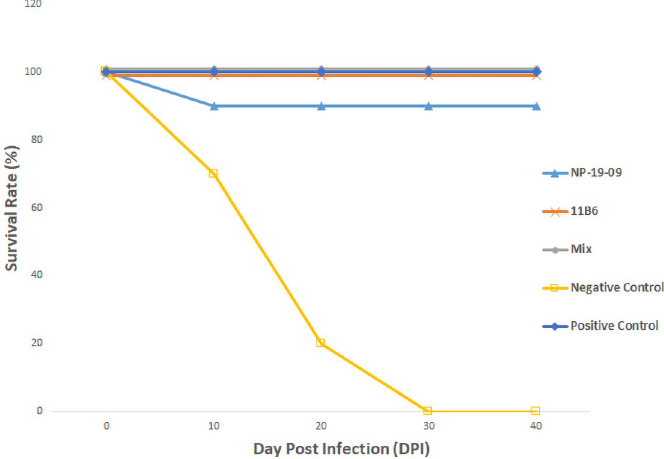
Fig 3. Efficacy of mAbs after rabies virus infection. Ten mice were tested and were injected with 100MICLD50 rabies virus before mAb administration. The graph demonstrates either NP-19-9 or 11B6 alone and cocktail administration all effectively protect tested mice from rabies virus